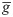
Major effects of I
Na on PN response characteristics.Effects of g-
Na, V
0.5act, S
m and S
h on E1 and I duration (left panel) and mean firing frequency of E1 and E2 (right panel).